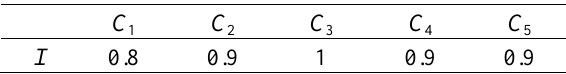
Table 2. Characteristics of the ideal investment